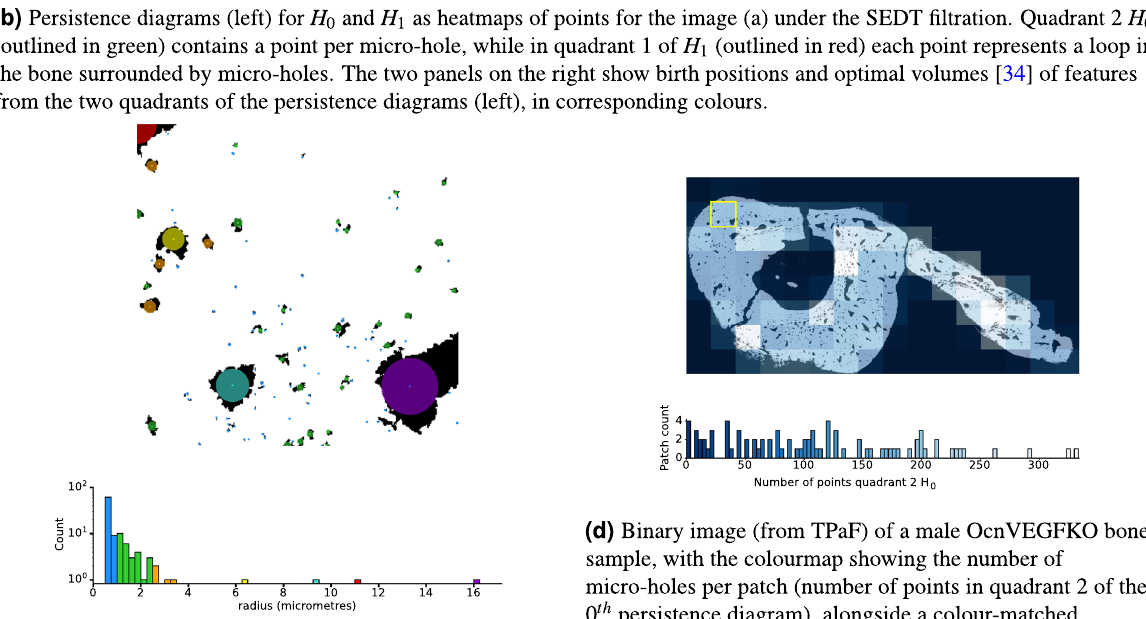
Figure 4. Persistent homology micro-hole structure analysis in a greyscale microscopy